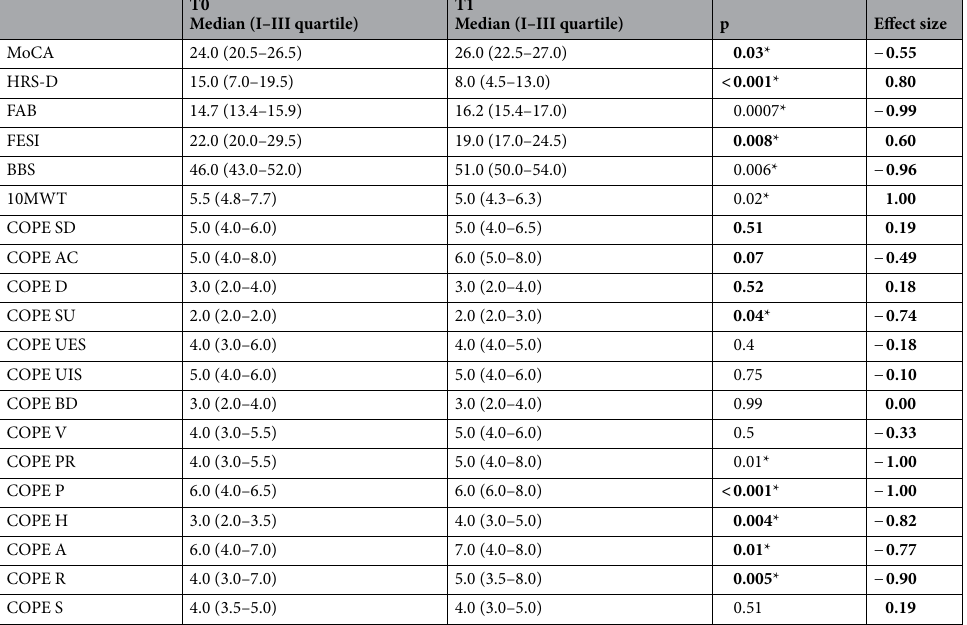
Table 1. Clinical characteristics at T0 and T1. *p < 0.05; MoCA Montreal cognitive assessment, HRS-D Hamilton rating scale for depression, FAB Frontal assessment battery, FESI Falls efficacy scale